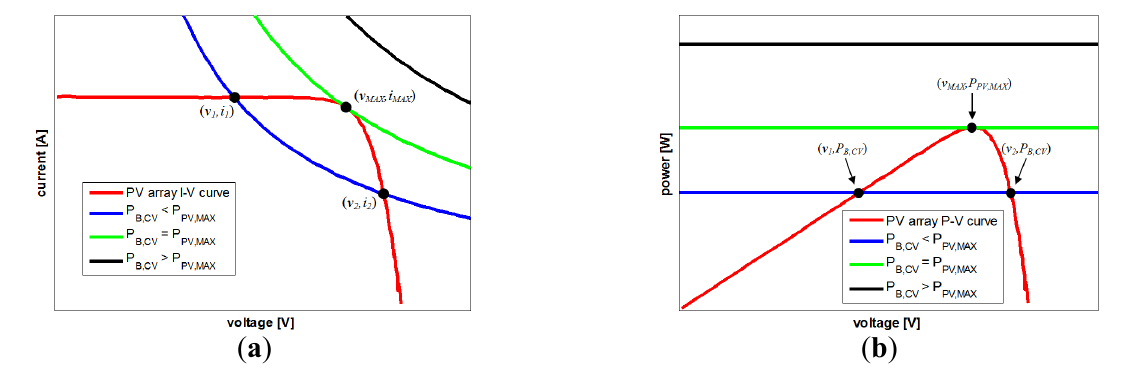
Figure 7. Solar Array (SA) operating points: ( a ) I-V plane; ( b ) P-V plane.